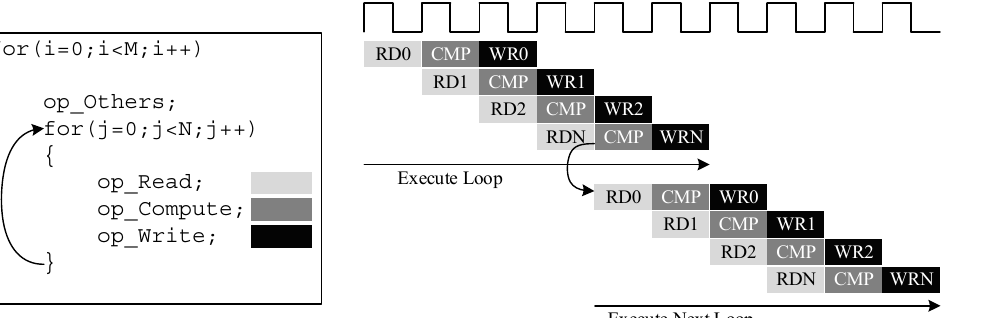
Figure 8. Loop pipelining without rewind.